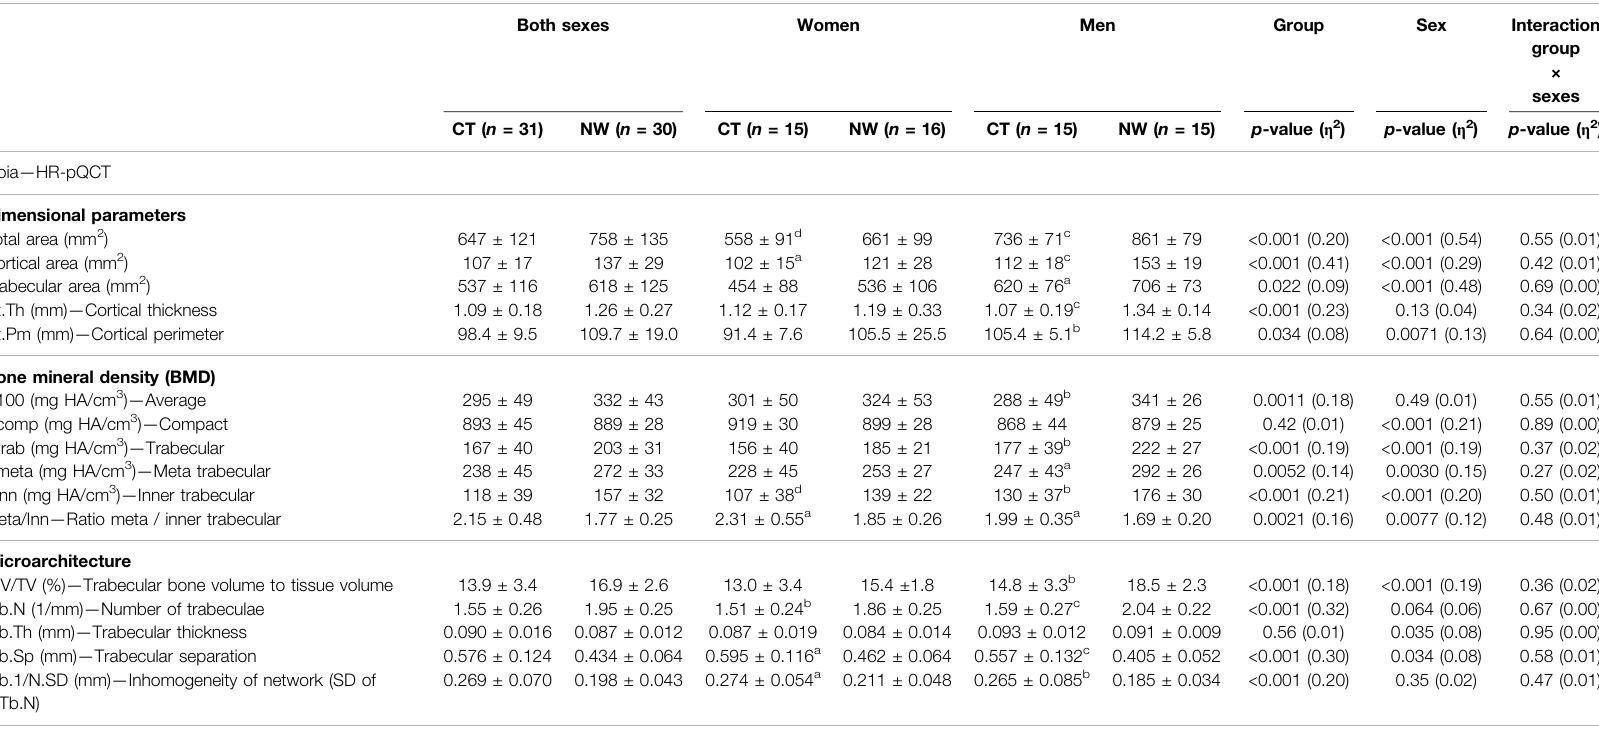
TABLE 2 | Bone architecture parameters of the distal tibia assessed using high resolution peripheral quantitative computed tomography in women and men with constitutional thinness compared with normal weight